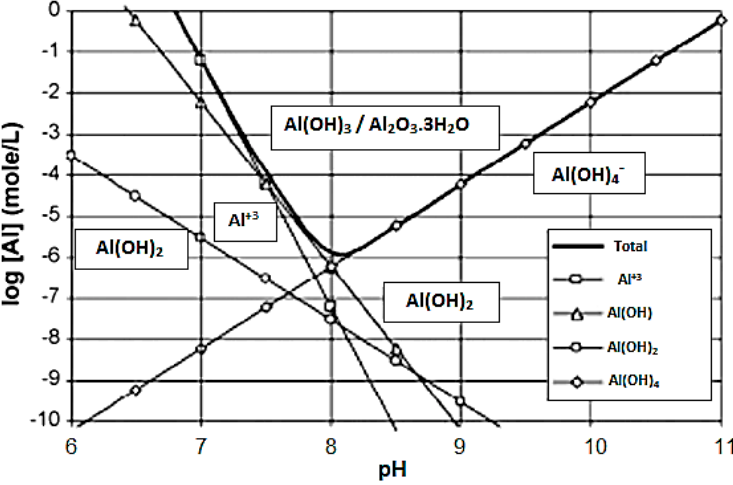
Figure 5. Aluminum hydrolysis solubility diagram.